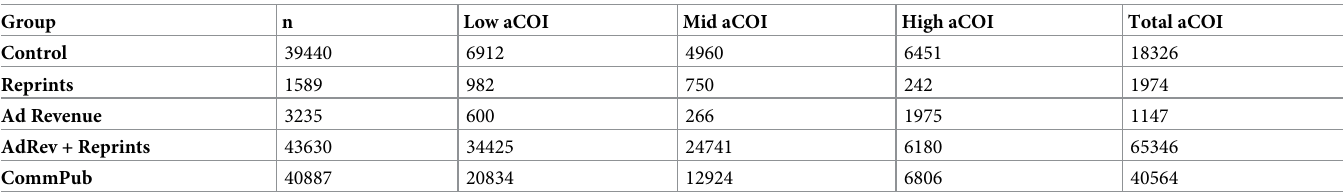
Table 2. Number of articles and aCOI rates by journal commercial relationships